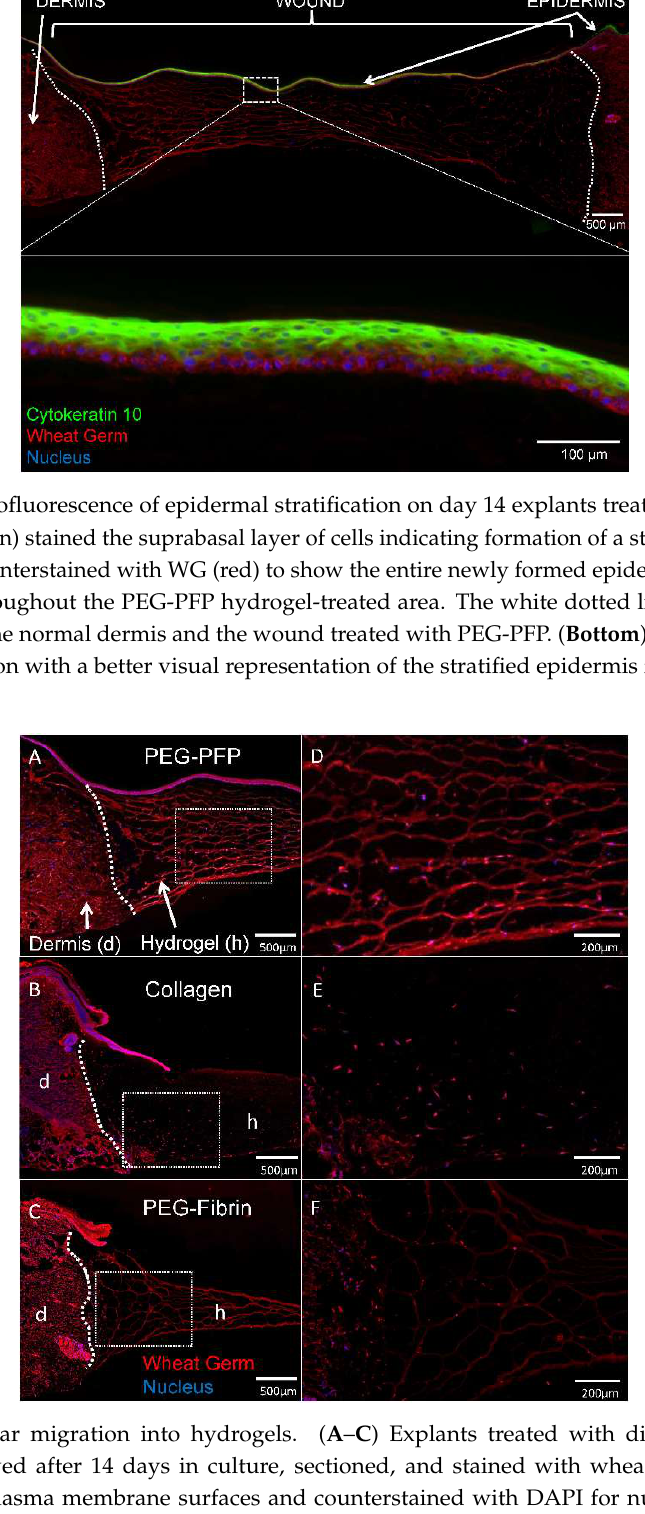
Figure 6. Cellular migration into hydrogels. ( A – C ) Explants treated with different hydrogels were cryopreserved after 14 days in culture, sectioned, and stained with wheat germ (WG, red) to visualize all plasma membrane surfaces and counterstained with DAPI for nuclei (blue). Cells originating in the dermis of the explant can be seen infiltrating and migrating into the hydrogels. White dotted line represents the boundary of the normal dermal tissue (d) and hydrogel (h) in the wound. ( D – F ) Respective enlarged images of sectioned hydrogels demonstrate cellular density of migrating